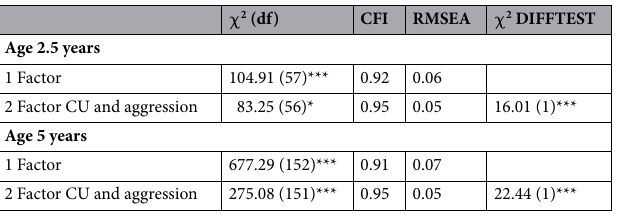
Table 2. Fit statistics and results of DIFFTEST for one versus two factor CU and aggression models. *** p < .001, * p <